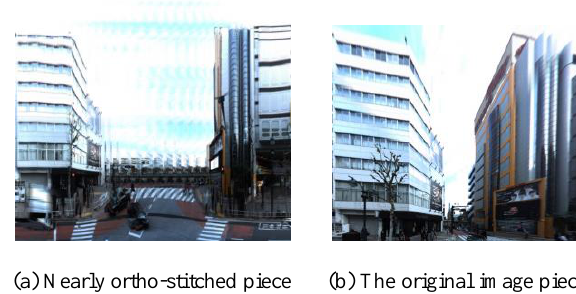
Figure 6. The nearly ortho-stitched part for a piece of deep street scene far away from the 3D mesh and its corresponding part on the original perspective